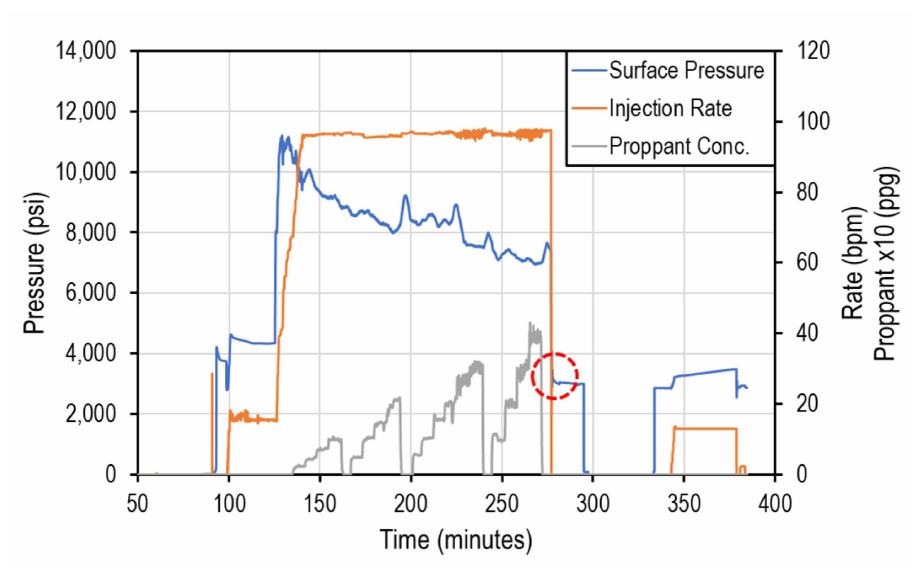
Figure 19. Typical treatment in Well #1.